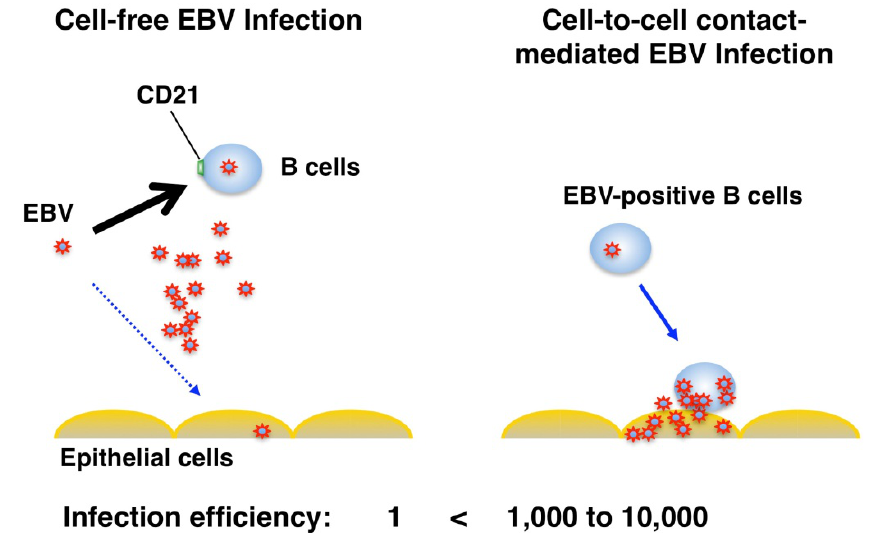
Figure 3. Cell-to-cell contact-mediated EBV transmission to epithelial cells. In cell-free infection, EBV preferentially infects B cells using CD21 receptor. EBV also infects CD21- negative epithelial cells as part of its normal life cycle, however much less efficiently. EBV transfer mediated by cell-to-cell contact with B cells increases the infection efficiency 1,000 to 10,000-fold compared with cell-free virus